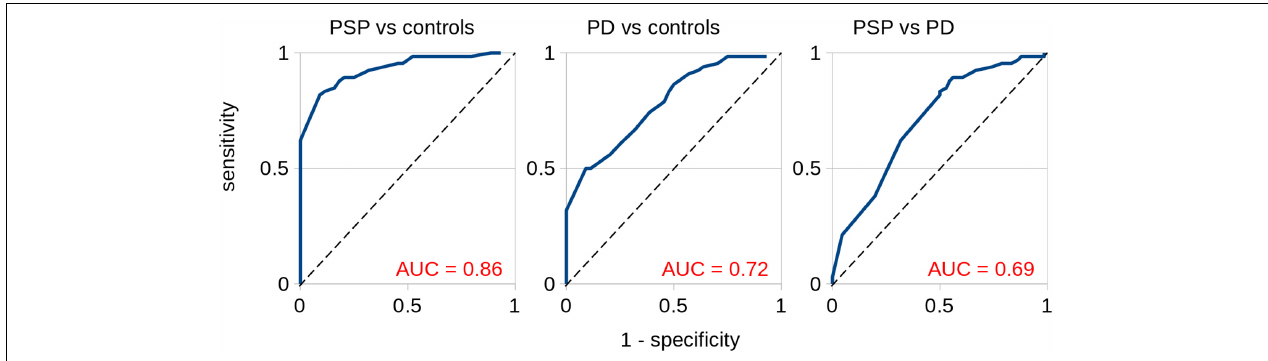
FIGURE 4 | Receiver operating characteristics for the combined score C of callosal area II. Separation for PSP vs. controls, PD vs. controls, and PSP vs. PD. The areas under the curve (AUC) values were 0.86 (excellent) for PSP vs. controls, 0.72 (acceptable) for PD vs. controls, and 0.69 (hardly acceptable) for PSP vs. PD.